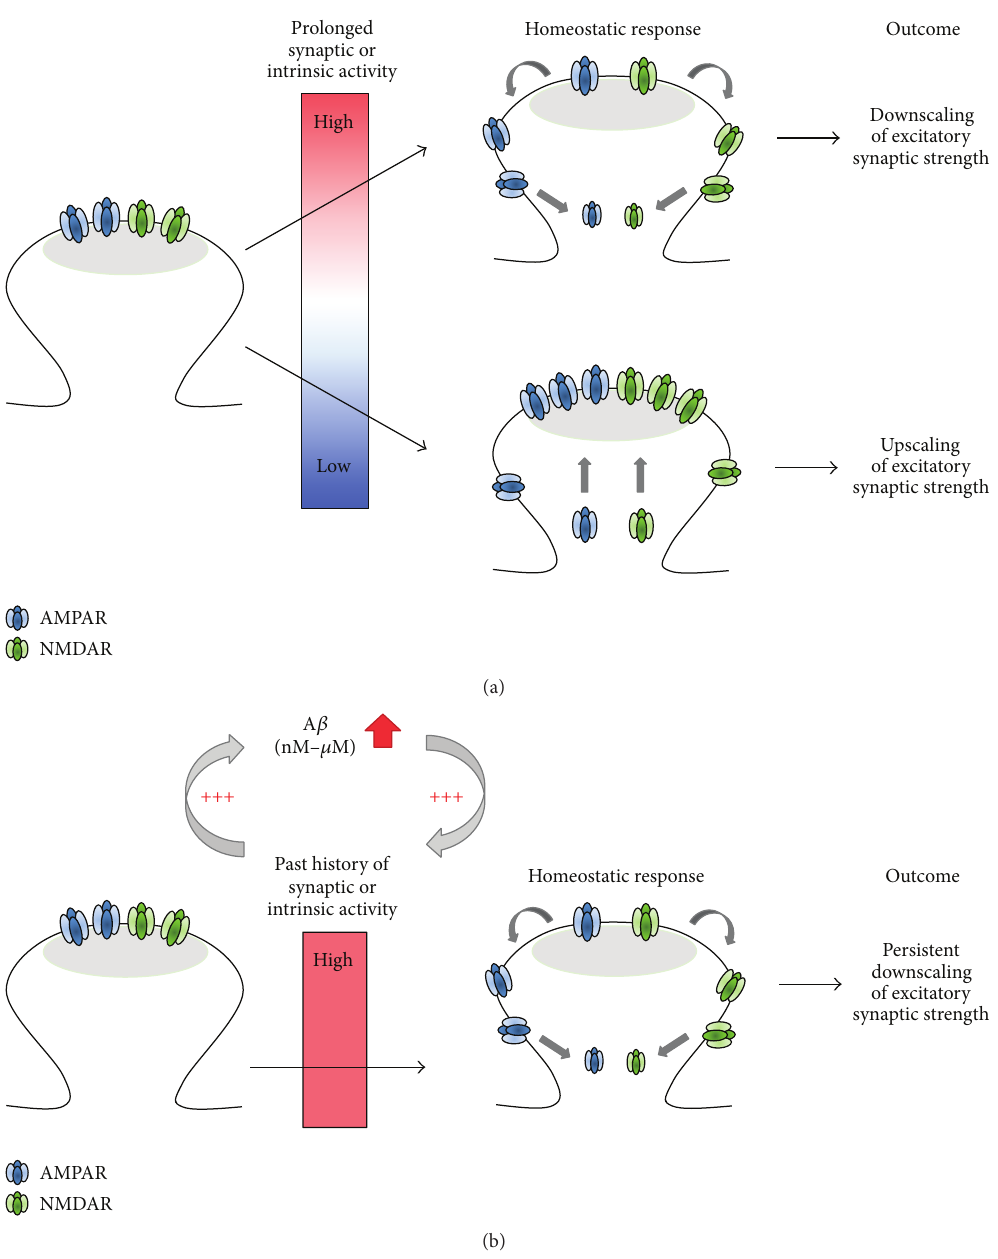
Figure3:PostsynapticexpressionmechanismsinnormalandADsynapses.(a)Innormalsynapses,chronicactivityblockadeleadstosynaptic scaling expressed by a compensatory increase in synaptic AMPAR density and current, whereas chronic activity elevation leads to synaptic downscaling expressed by a compensatory decrease in synaptic AMPAR density and current. (b) In AD, A 𝛽 increases neuronal excitability and/or synaptic activity, leading to induction of synaptic downscaling. Because pathologic feedback loop continues to produce and release A 𝛽 , synaptic downscaling becomes persistent and opposes the postsynaptic expression mechanisms for